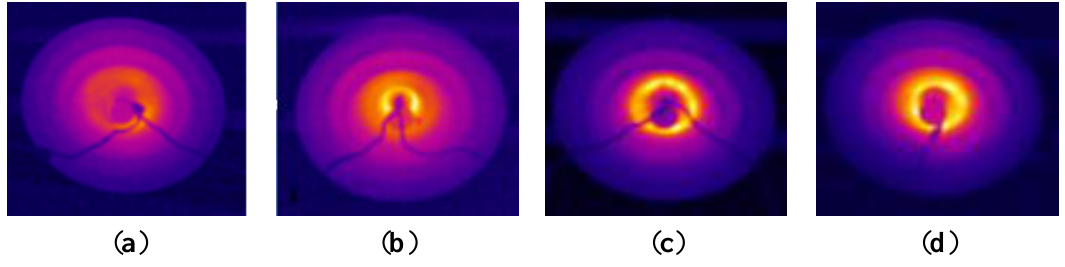
Figure 5. Infrared images of polluted insulators at 85% RH; ( a ) Insulator of I contamination grade; ( b ) Insulator of II contamination grade; ( c ) Insulator of III contamination grade; and ( d ) Insulator of IV contamination grade.